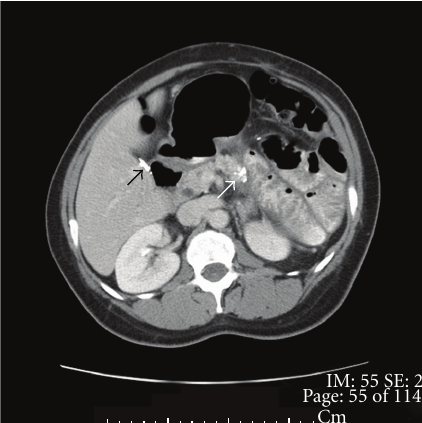
Figure 2: CT scan with contrast through the clavicle. There is increased sclerosis of the medial right clavicular head (white arrow) with a moth-eaten appearance of the cortex and medullary space. The di ff erential diagnosis is metastasis or chronic osteomyelitis. Biopsy subsequently showed metastatic pancreatic cancer.